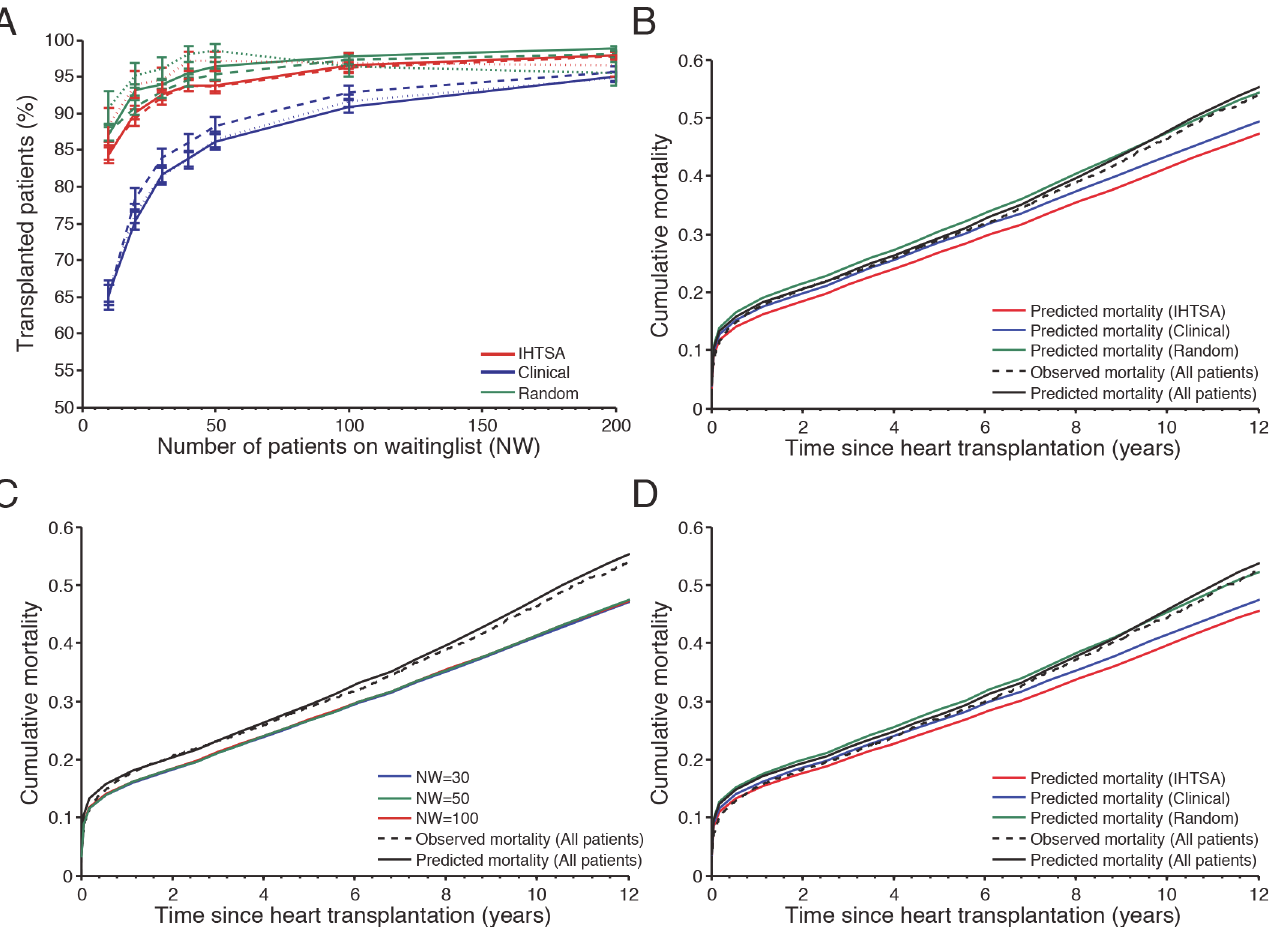
Fig 8. Predicted cumulative mortality for different organ allocation models. In panel (A) the graph shows the number of transplanted patients for The IHTSA model (red lines), Clinical model (blue lines) and Control (green lines) influenced by the size of the waiting list. The internal validation cohort (IVC) is presented with solid lines, temporal validation cohort (TVC) dashed lines and external validation cohort NTTD dotted lines. In panel (B) the graph shows the difference in predicted cumulative mortality as a function of time since heart transplantation for a waiting list including 50 patients in the IVC (N = 8,569). The solid black lines present the observed mortality and the dotted lines the predicted mortality for all patients. Panel (C) shows the difference in predicted cumulative mortality for IHTSA model influenced by the number of patients on the waiting list (NW). In panel (D) the results from the sub analysis including patients from the IVC, who were not treated in the intensive care unit and were not on life support prior to transplantation, are presented (N =